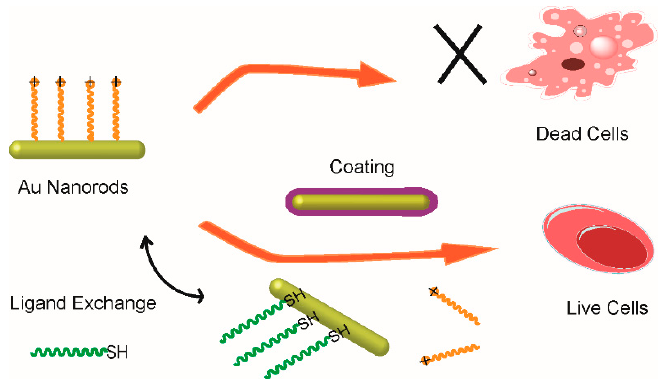
Figure 4. Schematic illustration of the surface modification of small gold nanorods by surface coating and ligand exchange methods.